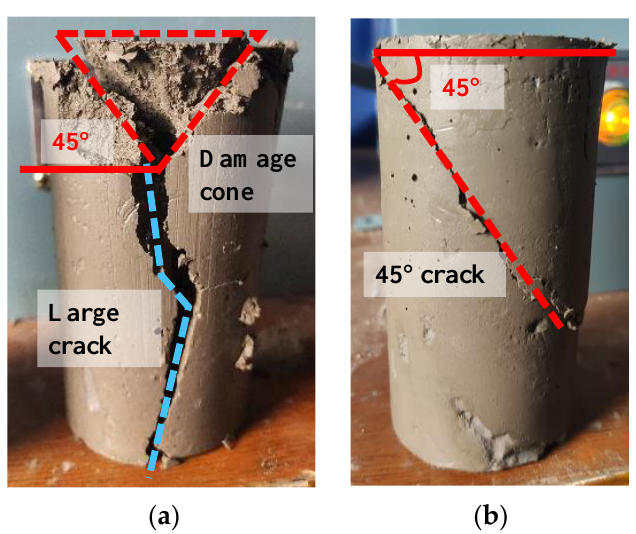
Figure 9. Failure modes for UCT specimens. ( a ) Triangular damage cone ( b ) Major crack.